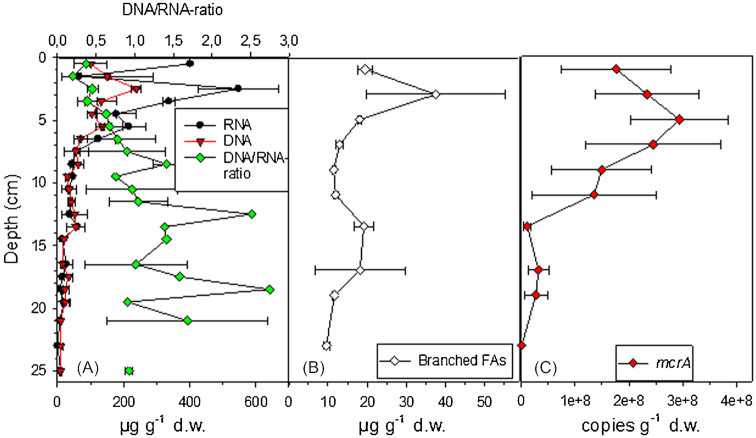
Vertical variation in the (A) amount of RNA and DNA as well as in the DNA:RNA—ratio, (B) amount of BrFA (sum of i14:0, i15:0, a15:0, i16:0, i17:0, a17:0 and i18:0) in PLFA fraction and (C)mcrA gene copy numbers in the sediments of the study lake. Results represent mean of two replicate cores and their average deviation. Depth of each data point is the average depth of the particular study layer. DNA:RNA—ratio could not be calculated for the layer 22–24 cm because RNA was below detection limit (in A).